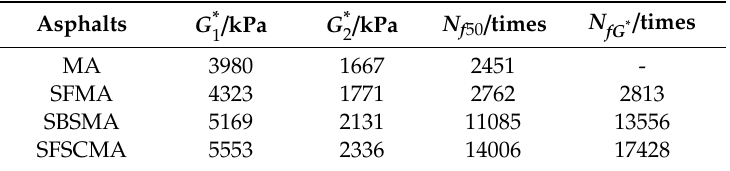
Table 12. Asphalt fatigue life test results.